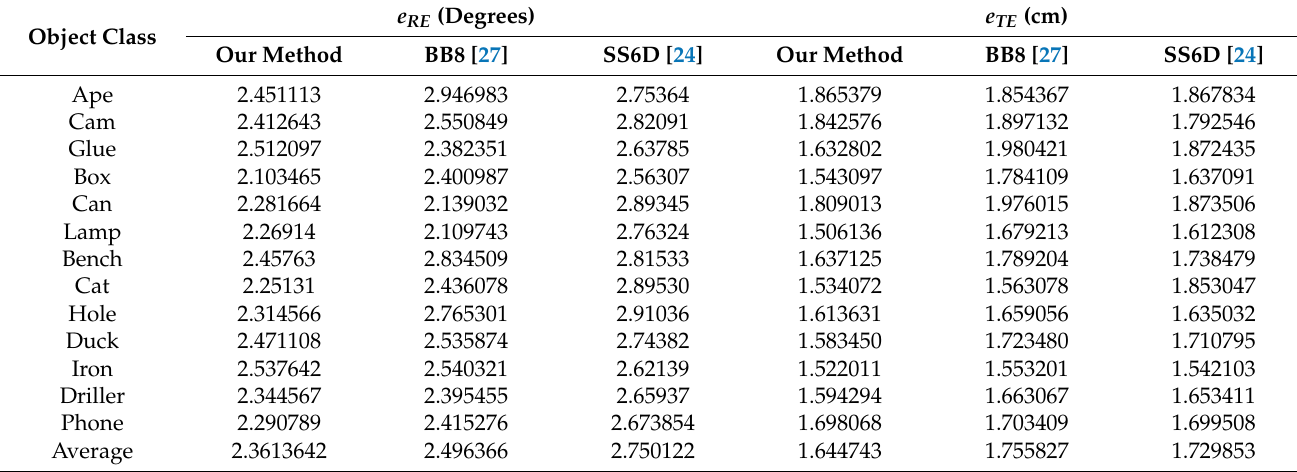
Table 2. Comparison of e TE and e RE results between our method, SS6D, and BB8 for 13